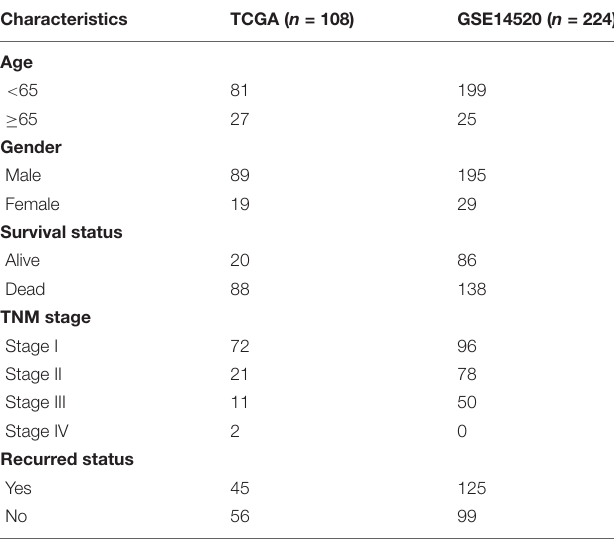
TABLE 1 | Clinical characteristics of HBV-related HCC